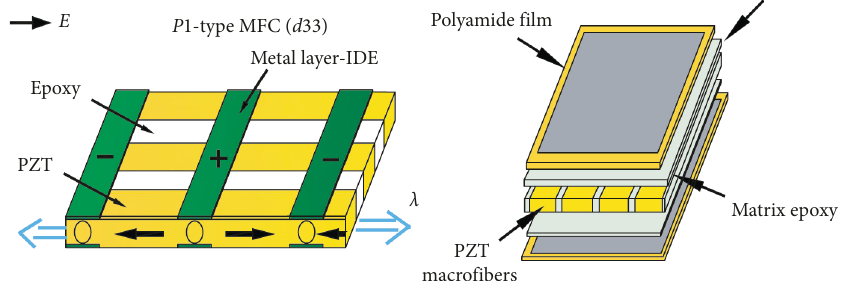
Figure 4: MFC- d 33